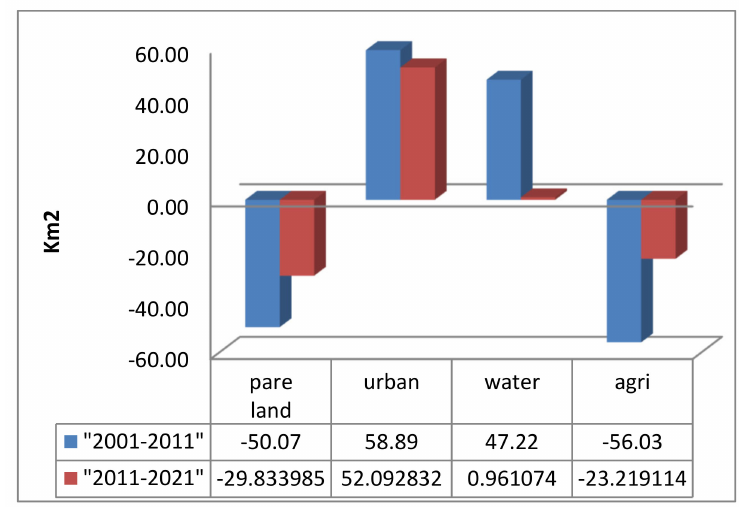
Figure 3. Increase/decrease in land cover (km 2 ).